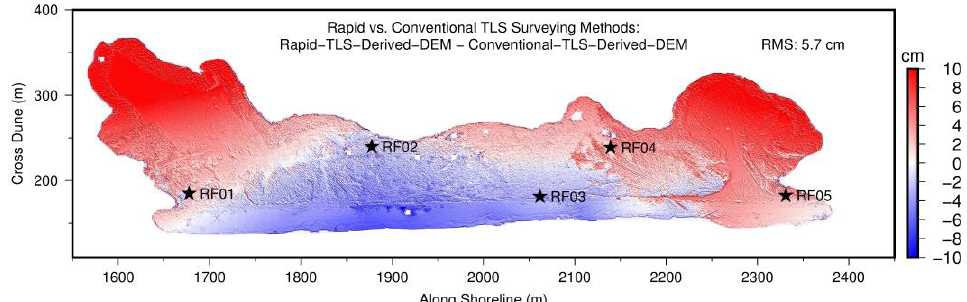
Figure 14. The difference between two DEMs derived from TLS datasets collected by the rapid surveying method and the conventional surveying method. Stars represent the locations of five reflectors with co-mounted GPS units (GPS-reflectors) that were used for georeferencing by the conventional surveying method.